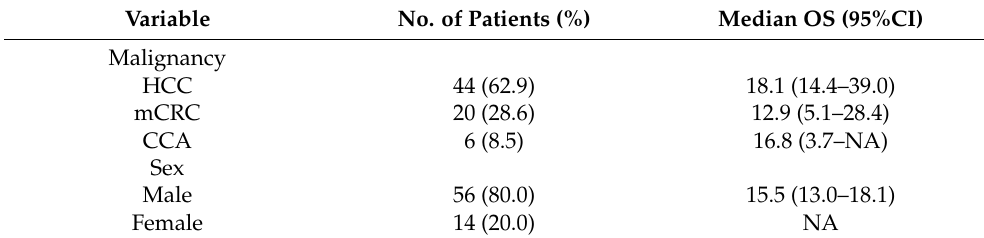
Figure 4. Overall survival. Kaplan-Meier analysis showing a median overall survival of 482 days (16.1 months) (range, 1–72.5 months) after Y90 TARE. Table 5. Kaplan-Meier estimates of overall survival (OS).